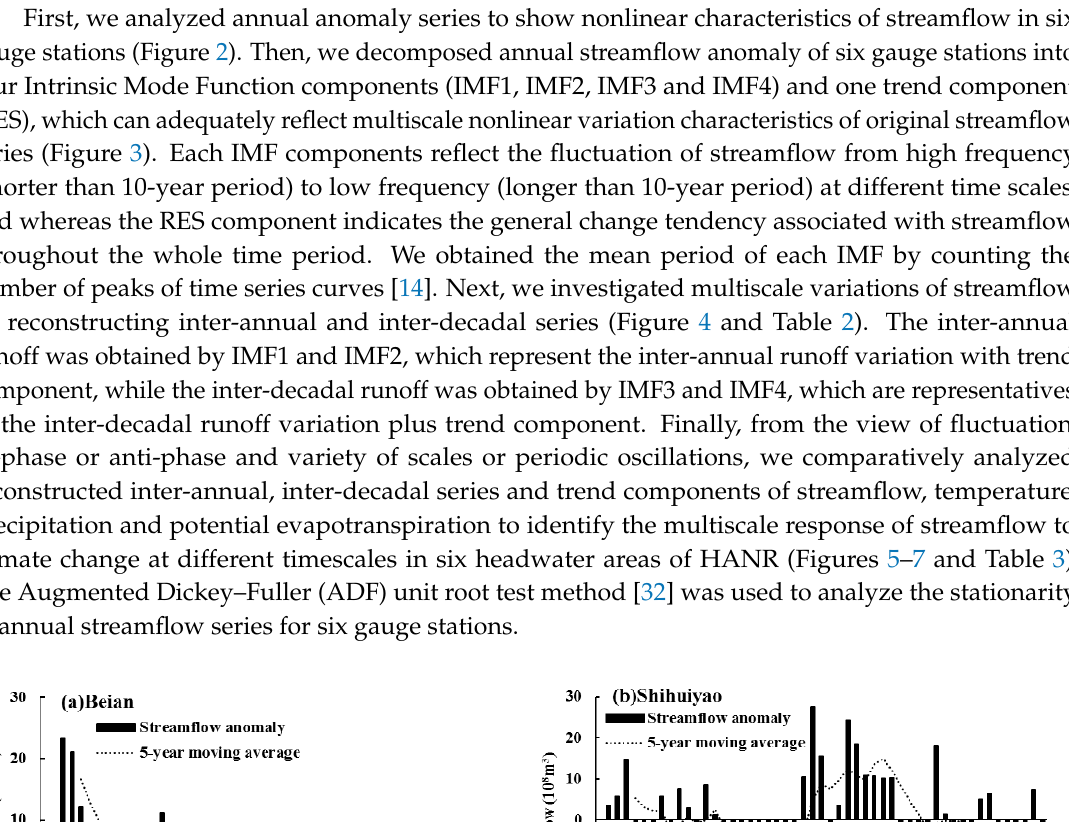
Figure 2. Annual streamflow anomaly against the 1961–2010 average and a five-year moving average trend at six gauge stations (( a ) Beian, ( b ) Shihuiyao, ( c ) Xiaoergou, ( d ) Zhalantun, ( e ) Suolun and ( f ) Tuliemaodu) in the headwater region of the Nenjiang River Basin, Northeast China.